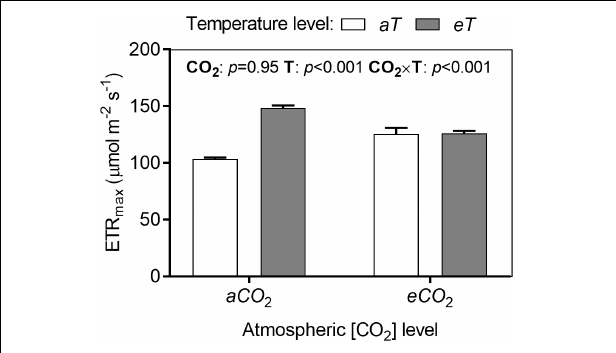
FIGURE 7 | Maximum electron transport rate (ETR max ) of S. capitata leaves under different levels of atmospheric [CO 2 ] and temperature at 66th day of experiment at maximum PPFD (784 µ mol photons m − 2 s − 1 ). [CO 2 ] levels: ambient ( aCO 2 ) and elevated ( eCO 2 , 600 µ mol mol − 1 ). Temperature levels: ambient ( aT ) and elevated ( eT , +2 ◦ C above ambient canopy temperature). ANOVA p -values are shown for main effects (CO 2 or T) or interactions CO 2 × T. Stack bars indicate the standard error.